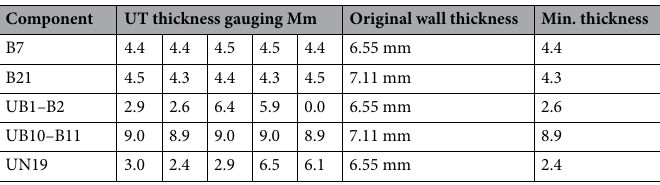
Table 7. Thickness measurements at the corroded